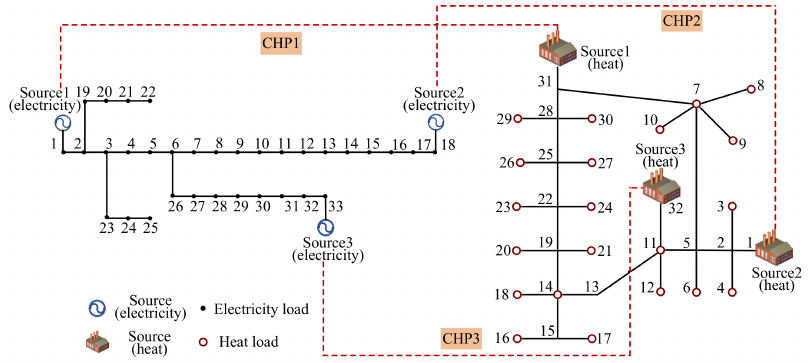
Figure 6. Structure of the Barry Island case (case study 2).